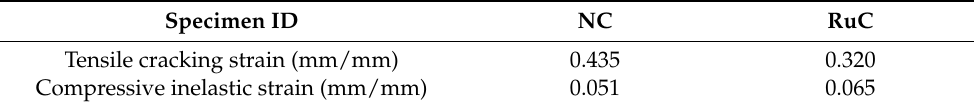
Table 3. The primary parameters of the CDP material model used in this